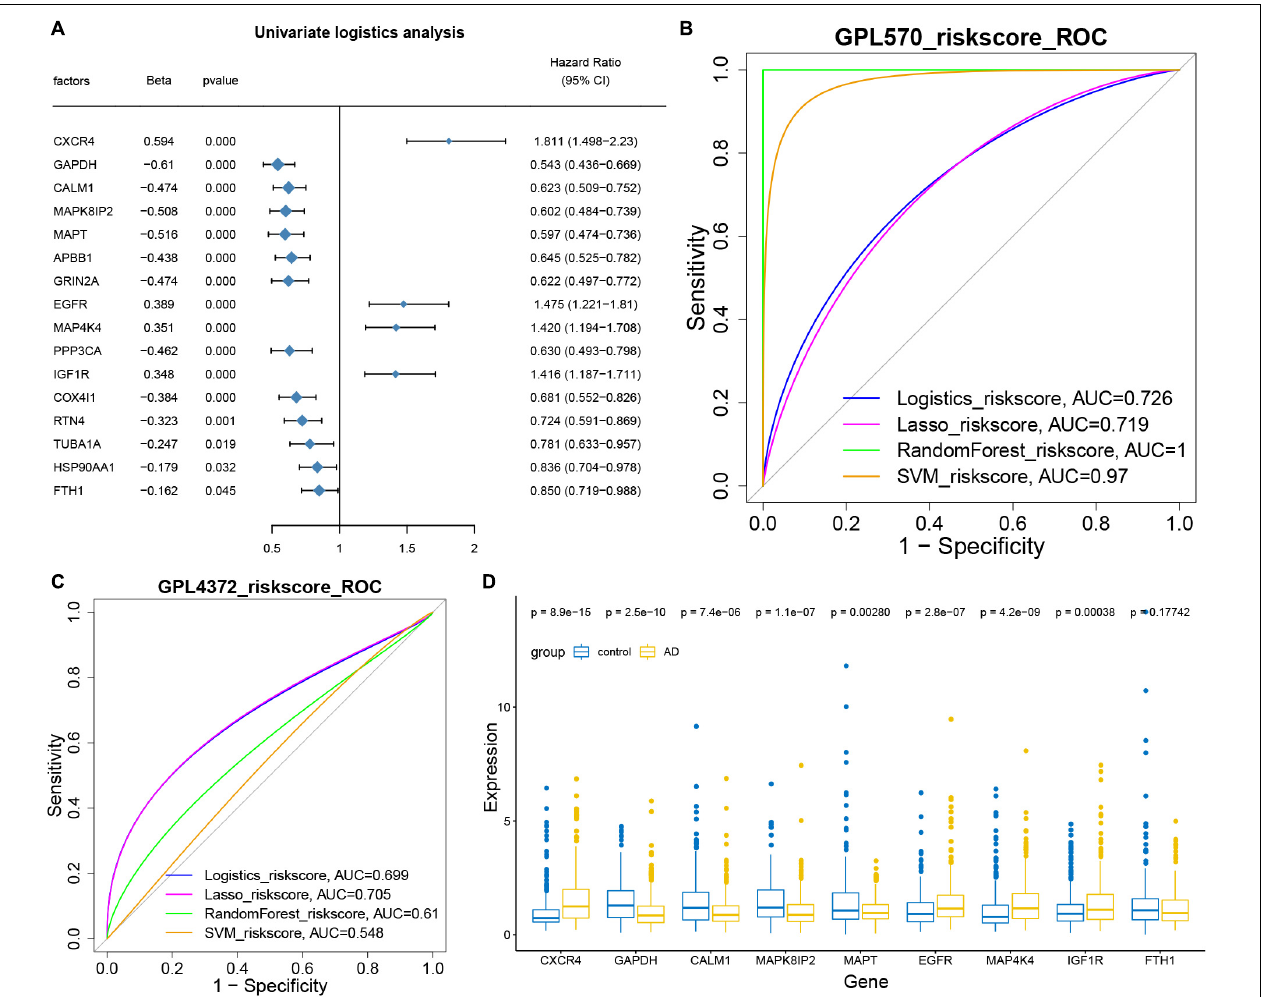
FIGURE 5 | Hub genes as biomarkers for the diagnosis of Alzheimer’s disease. (A) Forest map showing single-factor logistic diagnostic efficacy of potential mechanistic genes. CXCR4, EGFR, MAP4K4, and IGF1R emerged as disease risk factors. (B) AUCs for multivariate logistic, LASSO, random forest, and SVM modeling. All AUCs were more than 0.5 and therefore considered significant. (C) AUCs for the four models based on GSE33000 and GSE44772 datasets on the GPL4372 platform. AUCs were more than 0.5. (D) Box diagram showing the expression of core genes (model genes) in individuals with strong AD pathology or no/weak